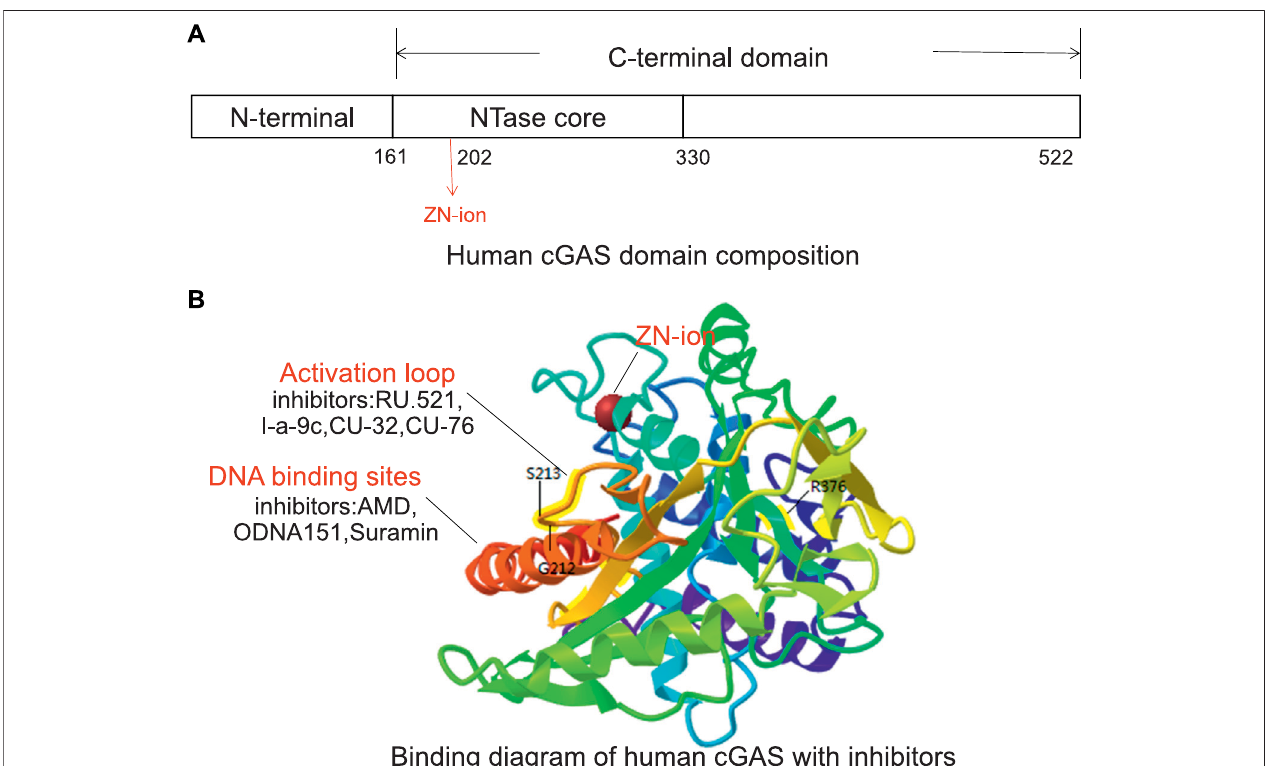
FIGURE 2 | The potential targeting sites of cGAS modulators, as shown on the X-ray crystal structure of human cGAS (Adopted from PDB ID: 4KM5). (A) Human cGAS domain composition. The human cGAS structure contains N-terminal helical extensions (amino acid residues 1 – 160) and C-terminal domains (amino acid residues 161 – 522). A unique zinc ion is located at position 202. (B) Binding diagram of human cGAS with inhibitors. The G212, S213, and R376 sites in the activation loop arethekeysitesofcGASbingingsubstrate(ATP+GTP). Theinhibitors thattargetDNAbindingsitesinclude AMD, ODNA151,and suramin,and theinhibitors targeting ATP and GTP binding sites include RU.521, CU-32, CU-76, and